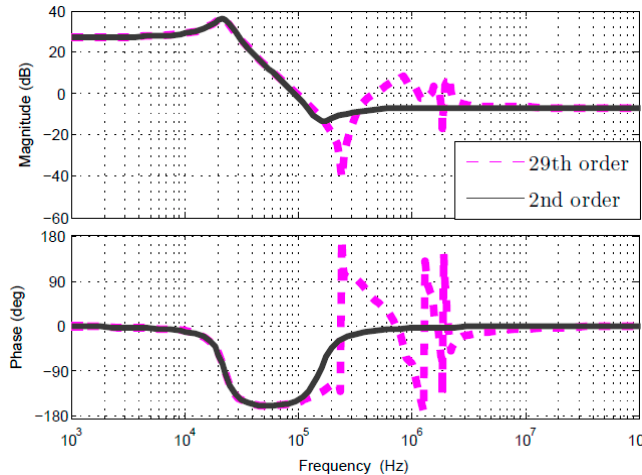
Figure 12. Coherence plot between system input and output signal.